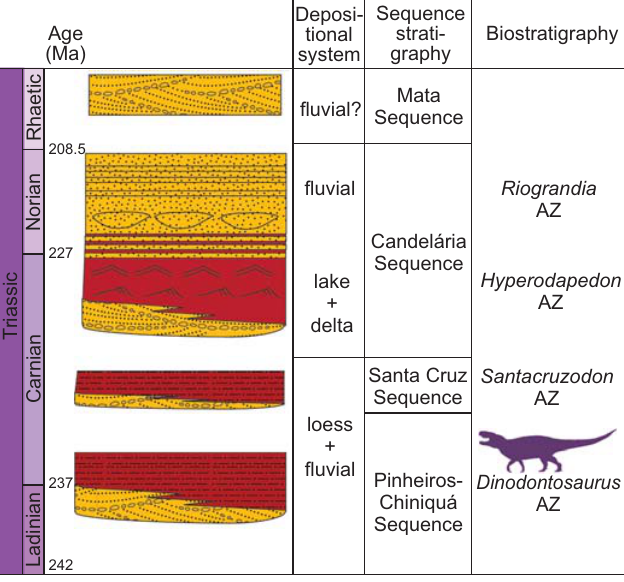
Fig. 1. Stratigraphic framework of the Triassic package from southern Brazil. Modified from Horn et al. (2018).